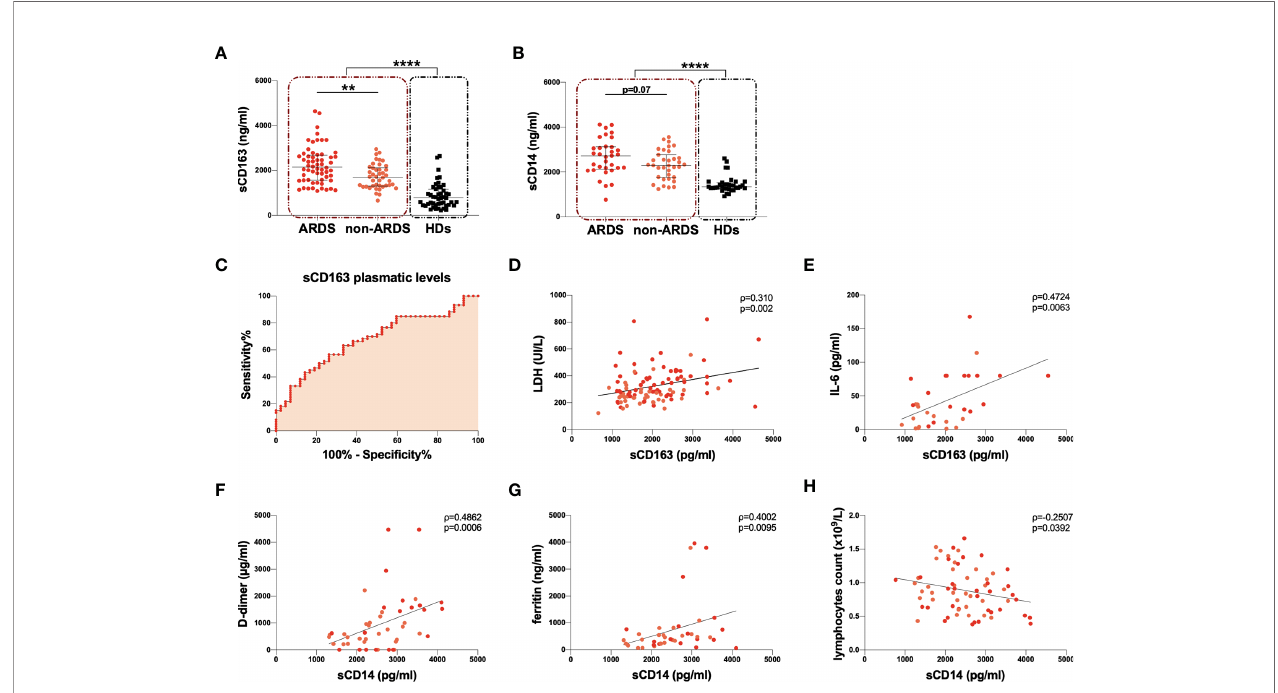
FIGURE 2 | Evaluation of sCD163 and sCD14 plasmatic levels and correlations with clinical data. (A) sCD163 plasmatic levels were evaluated in 102 COVID-19 subjects (red dashed line box) and 47 healthy donors (HDs) (black dashed line box). The differences were evaluated using the nonparametric Mann-Whitney test. Moreover, sCD163 plasmatic levels were evaluated in 60 patients with acute respiratory distress syndrome (ARDS) (ARDS group) and 42 patients without ARDS (non-ARDS group). Differences were evaluated using the nonparametric Mann-Whitney test. Data are shown as median (lines) and interquartile ranges (whiskers). (B) sCD14 plasmatic levels were evaluated in 68 COVID-19 subjects (red dashed line box) and 35 HDs (black dashed line box). The differences were evaluated using the nonparametric Mann-Whitney test. Moreover, sCD14 plasmatic level was evaluated in 33 patients with ARDS (ARDS group) and 35 patients without ARDS (non- ARDS group) using the nonparametric Mann-Whitney test. Data are shown as median (lines) and interquartile ranges (whiskers). (C) ROC analysis was performed using sCD163 plasmatic levels after strati fi cation of COVID-19 subjects according to the severity of the disease. The area under the curve is 0.6786 with p=0.0022. The cut-off of >2,023 pg/ml was identi fi ed with the Youden ’ s test and showed a sensitivity of 56.7% (CI: 44.1% to 68.4%) and a speci fi city of 73.8% (CI: 58.9% to 84.7%). CI: con fi dence interval. (D) Positive correlation between sCD163 and lactate dehydrogenase (LDH) plasmatic levels on 102 COVID-19 subjects. Linear correlation was evaluated by using the regression test, R 2 = 0.099, p=0.001. Patients with ARDS are represented in red, while patients without ARDS in orange. (E) Positive correlation between sCD163 and IL-6 plasmatic levels on 32 COVID-19 subjects. Linear correlation was evaluated by using the regression test, R 2 = 0.242, p=0.004. Patients with ARDS are represented in red, while patients without ARDS in orange. (F) Positive correlation between sCD14 level and D-dimer plasmatic levels on 46 COVID-19 subjects. Linear correlation was evaluated by using the regression test, R 2 = 0174 p=0.004. Patients with ARDS are represented in red, while patients without ARDS in orange. (G) Positive correlation between sCD14 and ferritin plasmatic levels on 41 COVID-19 subjects. Linear correlation was evaluated by using the regression test, R 2 = 0.101 p=0.043. Patients with ARDS are represented in red, while patients without ARDS in orange. (H) Negative correlation between sCD14 plasmatic levels and absolute count of lymphocytes on 68 COVID-19 subjects. Linear correlation was evaluated by using the regression test, R 2 = 0.058 p=0.048. Patients with ARDS are represented in red, while patients without ARDS in orange. All correlations were performed using Spearman test. Spearman coef fi cient ( r ) and statistical signi fi cance (p) are reported in the graphics. ****p<0.0001;